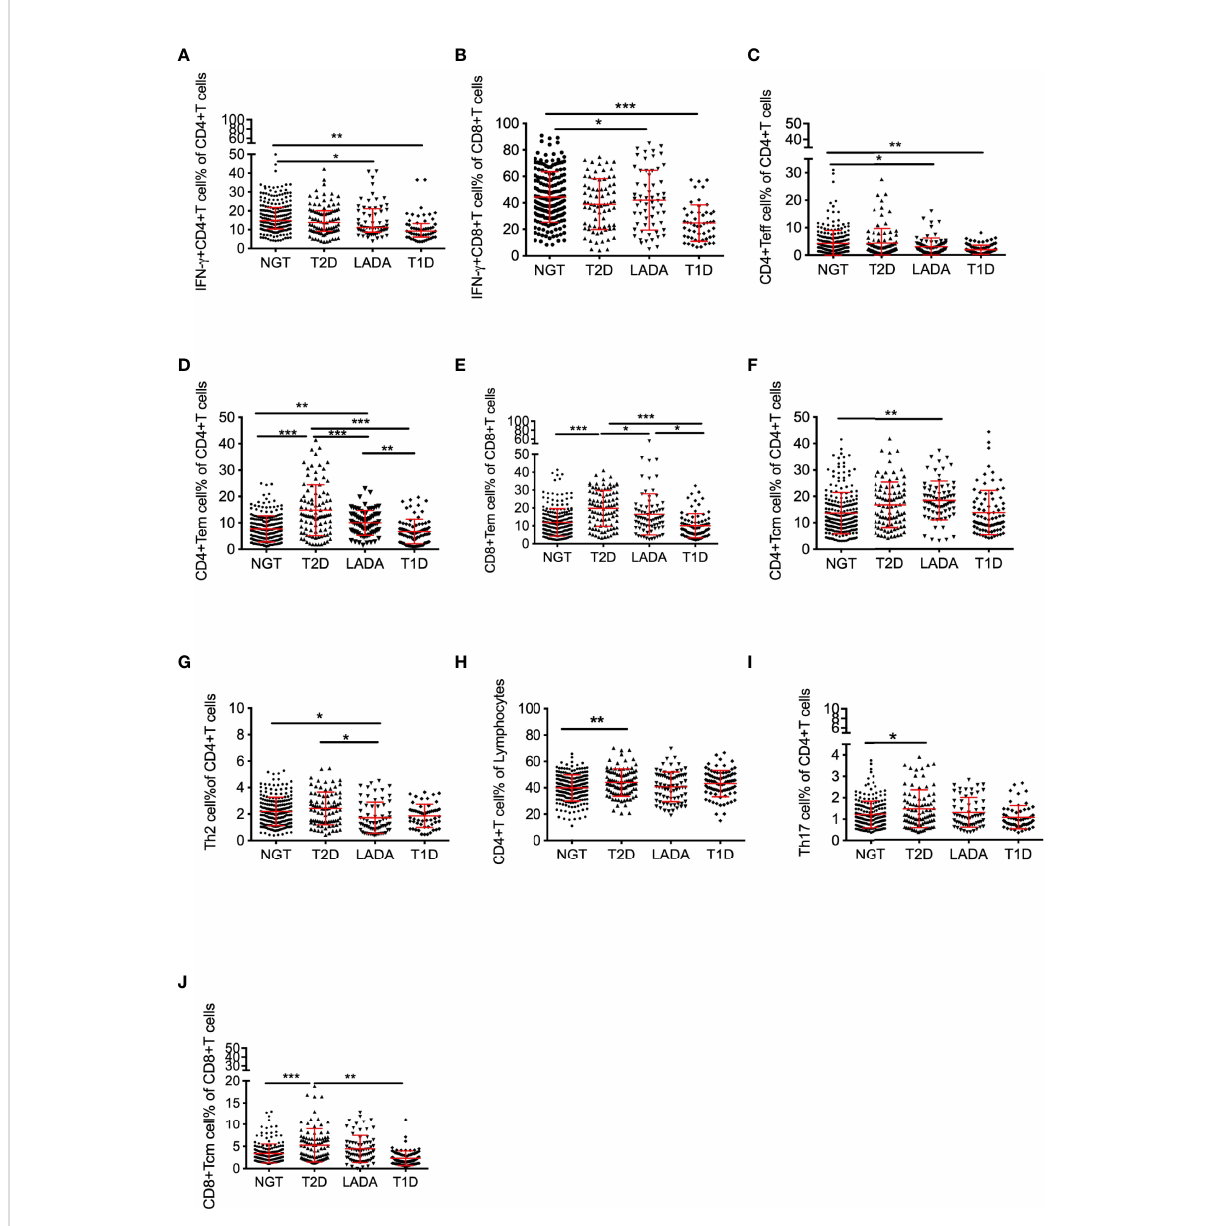
FIGURE 2 The frequency of peripheral T-cell subsets in diabetic patients and control subjects. The frequency of IFN- g + CD4 + T (A) and IFN- g + CD8 + T (B) cells gated on CD4 + T or CD8 + T cells, CD4 + Teff (C) and CD4 + Tem (D) gated on CD4 + T cells, CD8 + Tem (E) gated on CD8 + T cells, CD4 + Tcm (F) and Th2 cells (G) gated on CD4 + T cells, CD4 + T cells (H) gated on lymphocytes, Th17 cells (I) gated on CD4 + T cells, and CD8 + Tcm cells (J) gated on CD8 + T cells in NGT subjects and T2D, LADA and T1D patients as determined by fl ow cytometry. P values refer to comparisons of data after adjustment for age and sex. Each point represents the percentage of T-cell subsets of an individual. Graphs show the median and interquartile range. *p<0.05, **p<0.01,